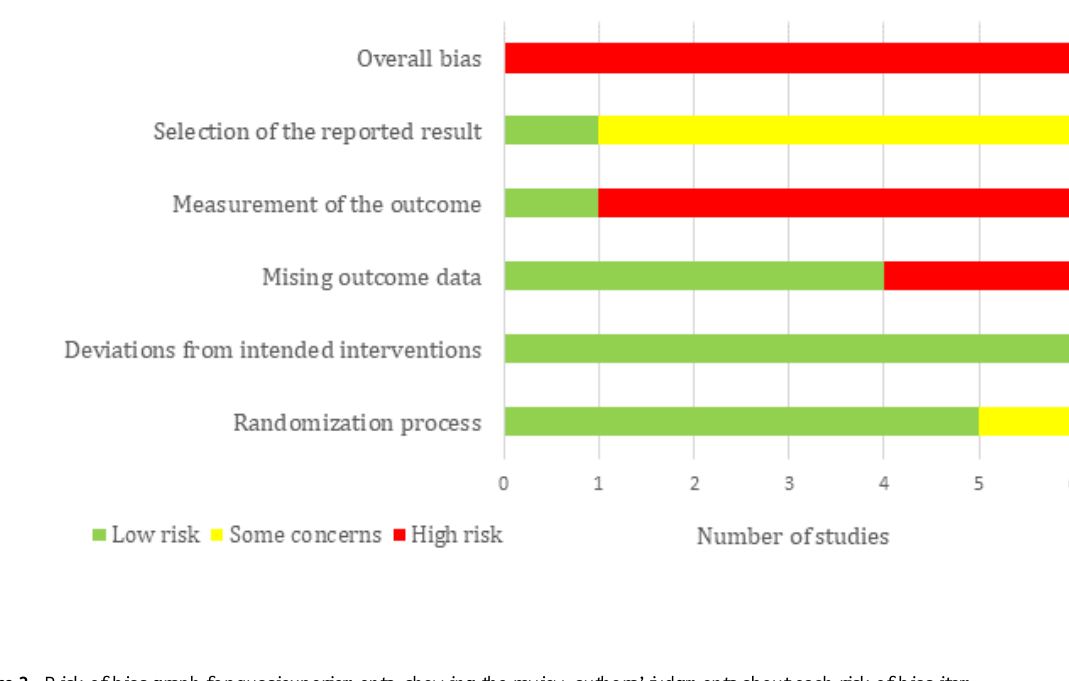
Figure 3. Risk of bias graph for quasiexperiements, showing the review authors’judgments about each risk of bias